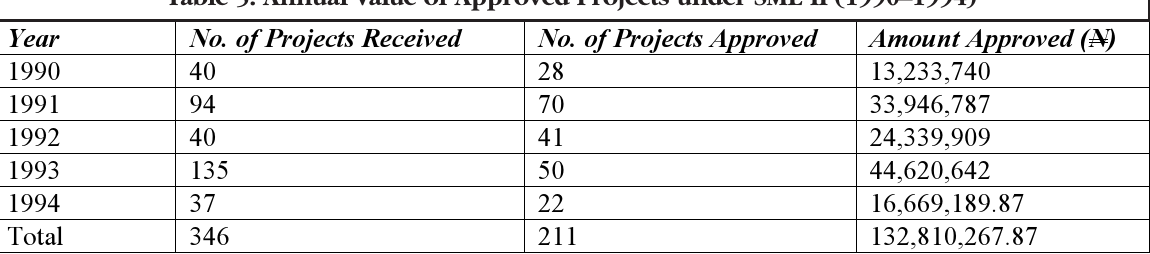
Table 5. Annual Value of Approved Projects under SME II